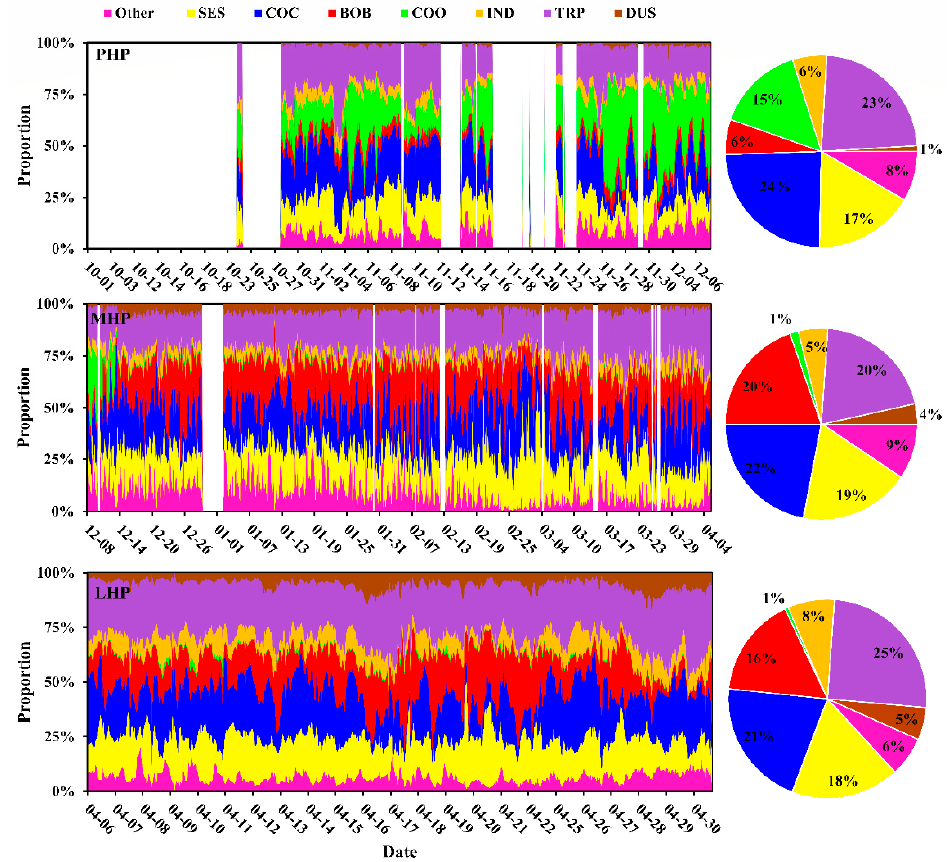
Figure 6. Temporal trend of source contributions to PM 2.5 during PHP, MHP and LHP.